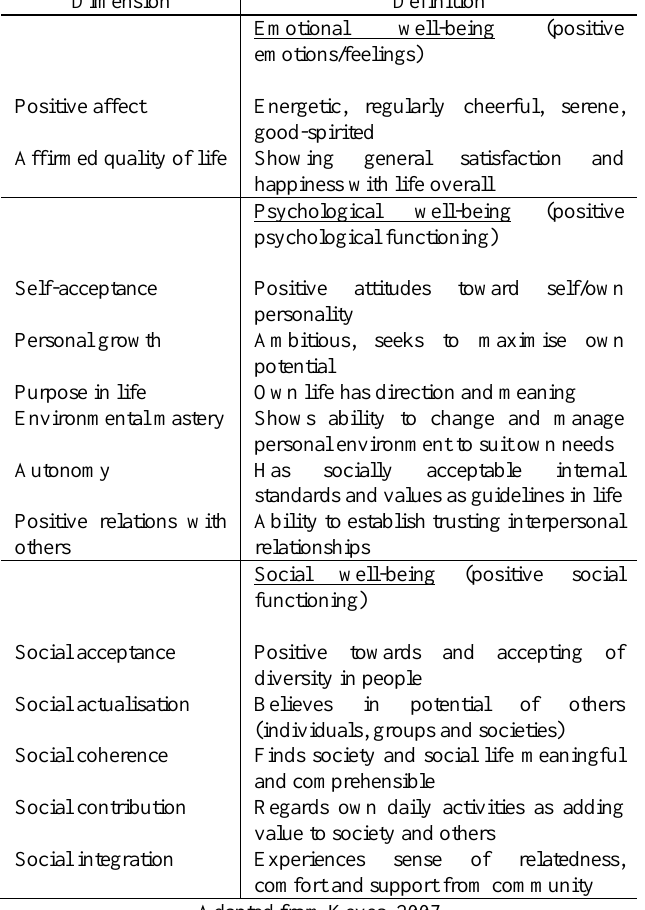
Table 1: Dimensions and factors reflecting mental